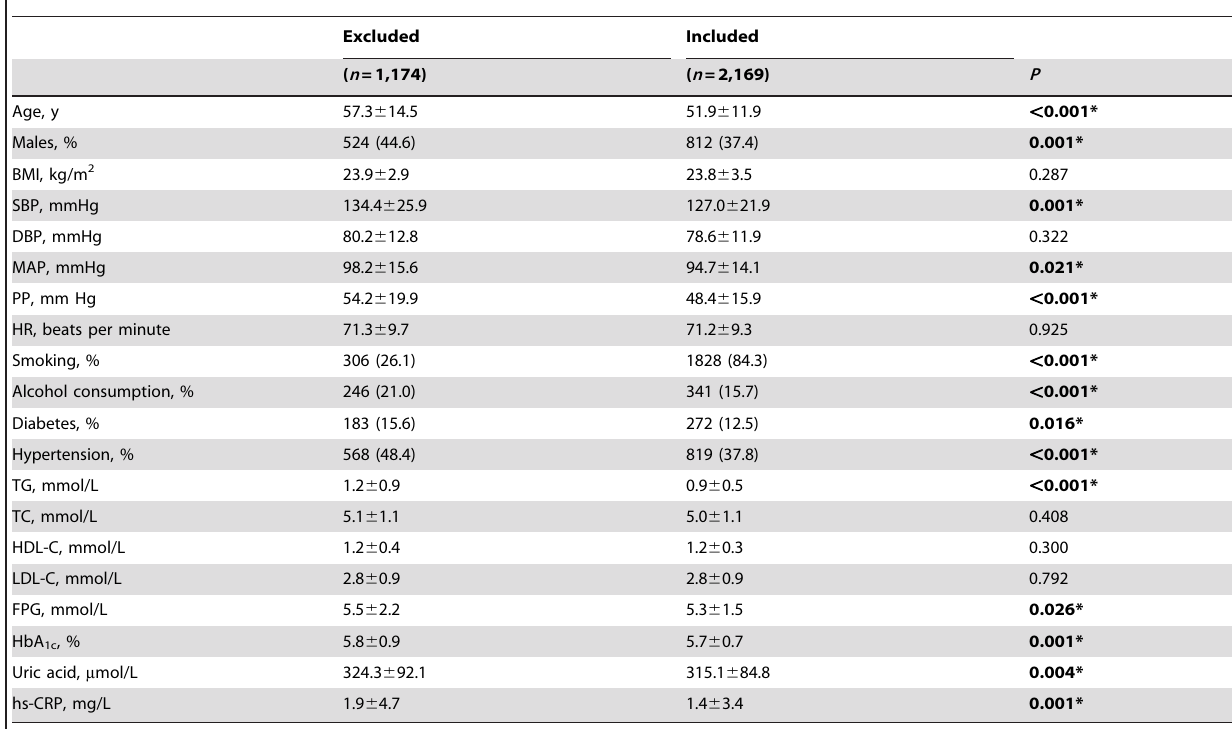
Table 1. Characteristics of the included and excluded subjects (N